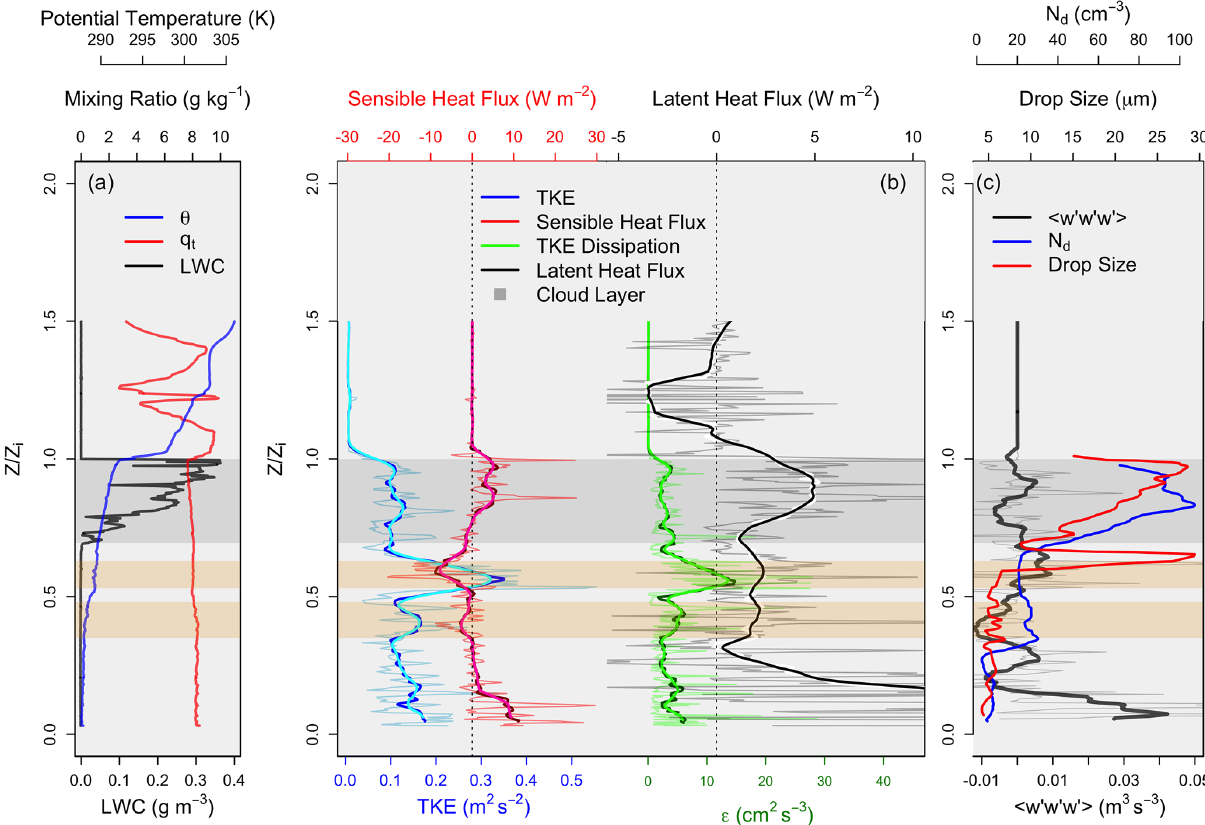
Figure 12. Vertical profiles as functions of normalized boundary layer height for RF11 (1 November) of (a) θ (K) in blue, q (gkg − 1 ) in red, LWC (gm − 3 ) in black, (b) TKE (m 2 s − 2 ) in blue, F θ (Wm − 2 ) in red, (cid:15) (cm 2 s − 3 ) in green, and F q (Wm − 2 ) in black. The thin light-colored lines represent raw values, while the dark thick lines represent smoothed averages; (c) (cid:10) w (cid:48) w (cid:48) w (cid:48) (cid:11) (m 3 s − 3 ) in black, N d (cm − 3 ) in blue, and the corresponding average droplet size (µm) in red. The gray envelope represents the cloud layer, and the orange envelopes represent areas of interest (main location of decoupling and